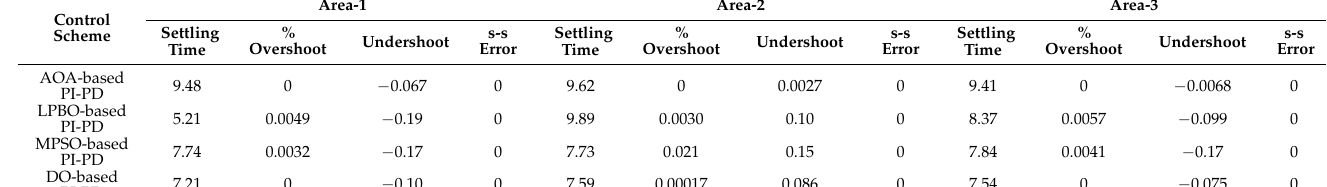
Table 13. Numerical results of LFC in a three-area multi-source IPS with nonlinearities.